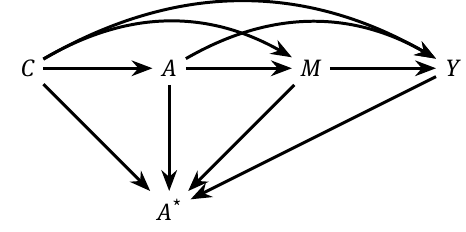
Figure 6: Differential misclassification in the measurement of exposure A * in mediation